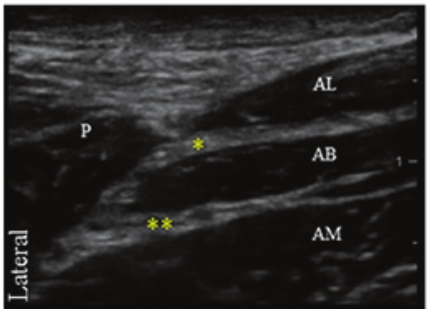
Figure 3: Transverse ultrasound image of the obturator nerve. The distal portion of the obturator nerve divides into an anterior division (single asterisk), identified between the adductor longus (AL) and brevis muscles (AB) and a posterior division (double asterisks) located between adductor brevis and magnus (AM) muscles. Pectineus muscle (P).